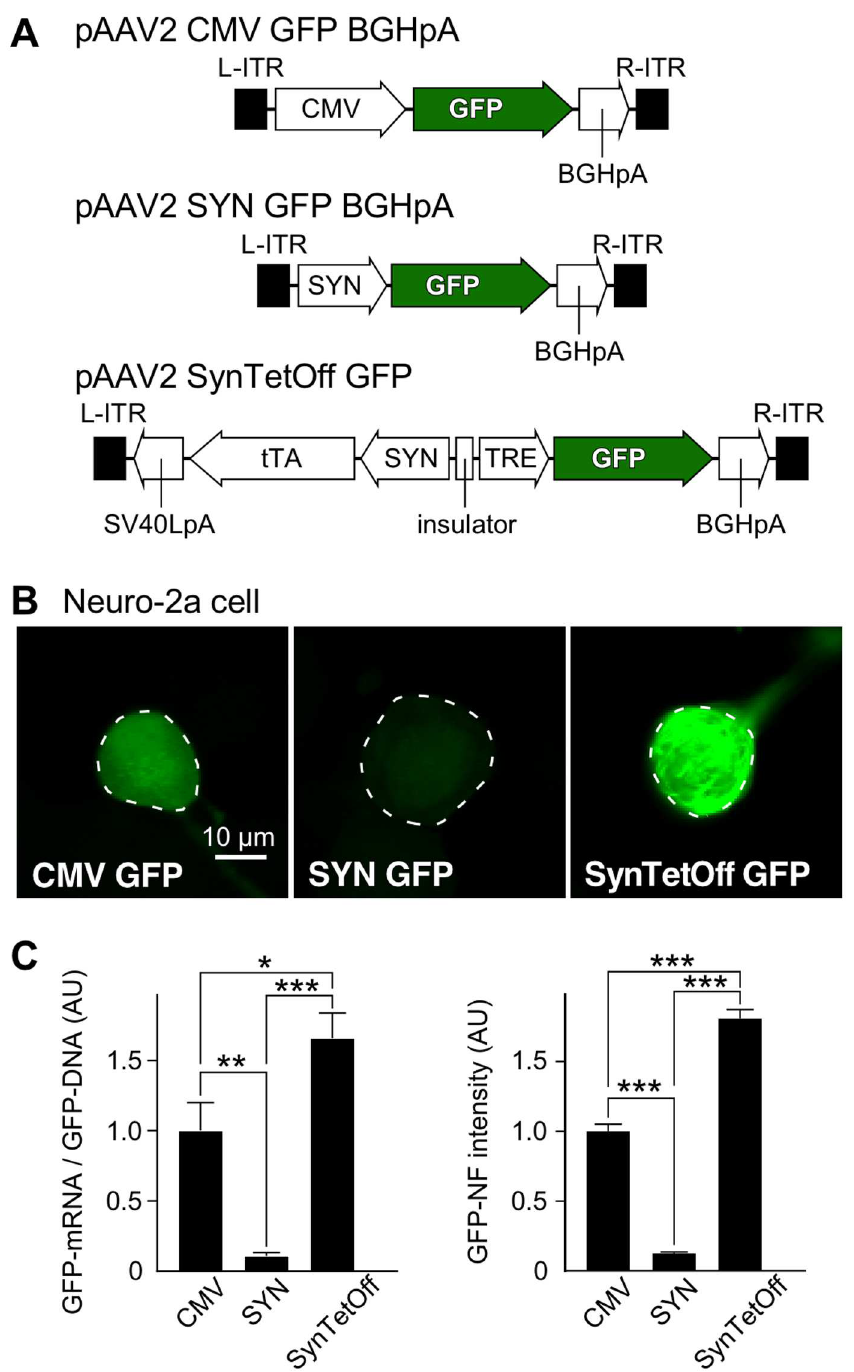
Fig 1. Efficient gene-transduction with AAV-SynTetOff vector in vitro . ( A ) Constructionof the vector plasmids,pAAV2-CMV-GFP-BGHpA, pAAV2-SYN-GFP-BGHpA, and pAAV2-SynTetOff-GFP. ( B ) One week after infectionof Neuro-2a cells with AAV2/1-CMV-GFP-BGHpA, AAV2/1-SYN-GFP-BGHpA, and AAV2/1-SynTetOff-GFP, GFP-NF intensities were measuredin the infected cells (outlinedby dotted lines with ImageJ). ( C ) The gene-transduction efficiency with AAV2/1-CMV-GFP-BGHpA, AAV2/1-SYN-GFP-BGHpA, or AAV2/1-SynTetOff-GFP was examinedquantitatively. The GFP-mRNA/GFP-DNA ratio and the GFP-NF intensity of cells infected with AAV2/1-CMV-GFP-BGHpA were standardized as 1 arbitrary unit (AU). A qRT-PCR assay revealedthat GFP-mRNA expressionwas 1.7- and 15.6-fold higher with